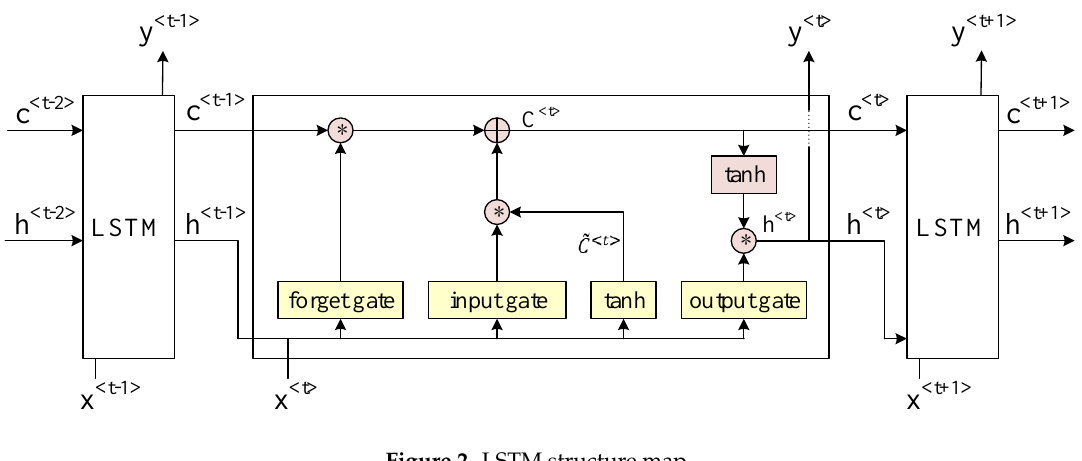
Figure 2. LSTM structure map.